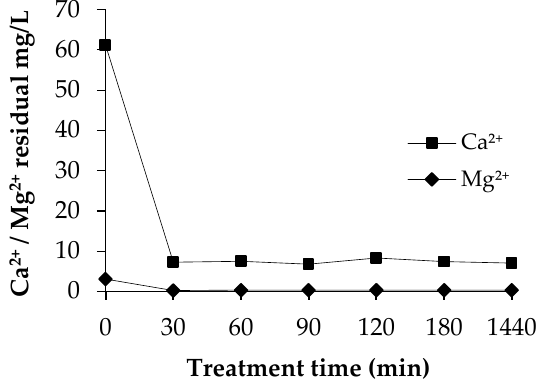
Figure 9. Inductively coupled plasma optical emission spectrometry (ICP-OES) characterization of the residual concentrations of Ca 2+ and Mg 2+ during the experiment, at 20 °C.